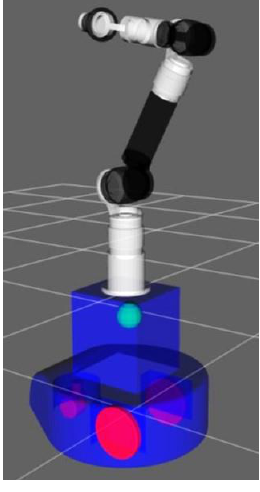
Figure 1. The virtual model of the coupled robotic systems.